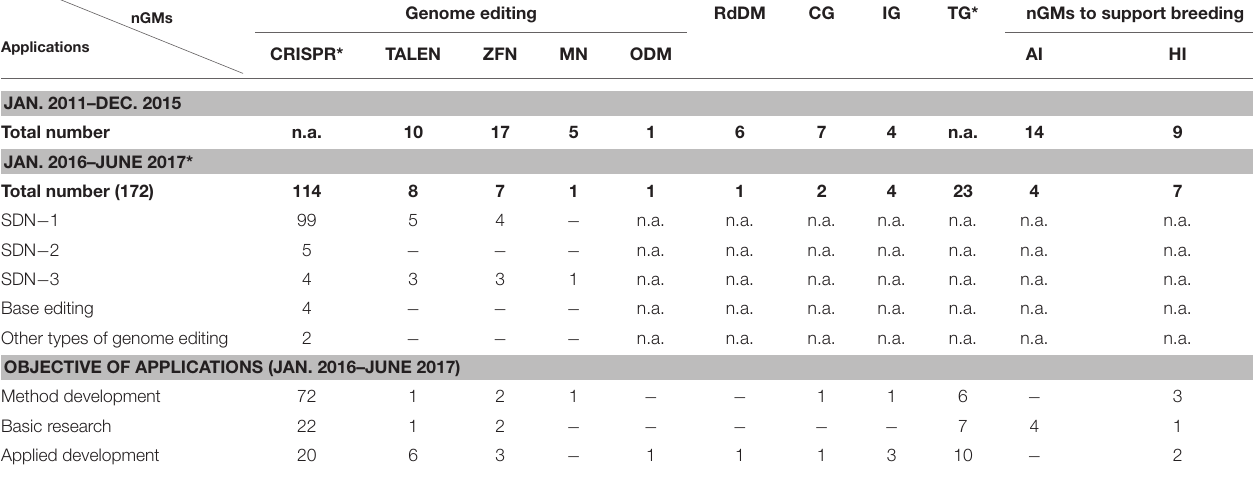
TABLE 2 | Research publications between 2011 and 2017 covering several applications for different nGMs.